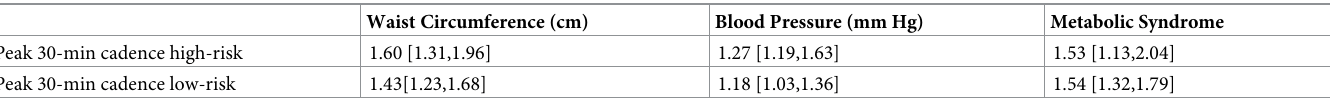
thresholds were highest for men in the 18–39 year age range, while thresholds for women were highest in the 50–59 year age range. Thresholds decline in older age bins, however, the sample sizes also decline as age increases. Decision tree analysis. Fig 2 represents the decision tree result for low-risk metabolic syn- drome. In Fig 2, spending virtually any time in the seventh cadence band ( � 120 steps/min), � 4.2 minutes in the fifth cadence band (80–99 steps/min), and � 9.8 minutes in the first cadence band (1–19 steps/min) would result in a person being classified as not at low-risk metabolic syndrome. Additionally, a person who does not spend any time in the seventh cadence band ( � 120 steps/min) would be classified as at-risk. When the observations were split into 1000 different training sets with 80% of the data reserved for training and 20% for testing, the tree correctly predicted an average of 66.3% of the locations in the test data sets. Table 5. Odd ratios derived from the logistic regression model with peak 30-min cadence and steps/day adjusted for age and